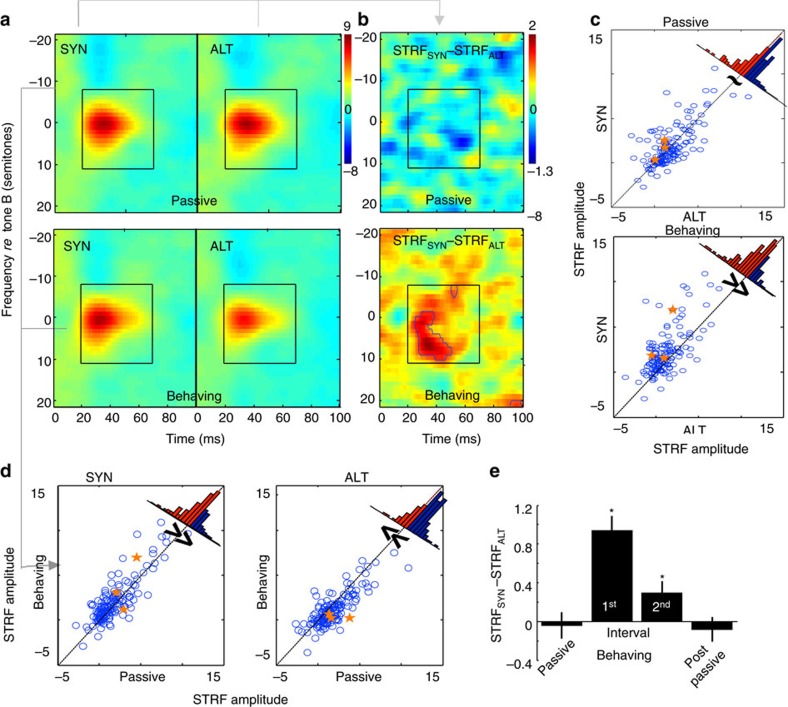
Average STRF changes across all cells.(a) Average STRF from all neurons in the passive and behaving states, and in two contexts: preceded by SYN or ALT sequences. The centers of the STRFs from all neurons were aligned at the CF of each neuron, which was typically near the frequency of the B tone sequence. The upper panels display the STRFs in the passive condition. The lower panels show the STRFs during behaviour. The highlighted central region is the window used for quantification and comparison. The same colour-scale is used for all STRFs. (b) Average differences in STRFs between SYN and ALT (STRFSYN-STRFALT). The upper panel shows that there were no significant STRF differences in the passive condition. During behaviour (lower panel), the STRF differences exhibit significant enhancement. The contours indicate the regions with statistically significant differences from zero (see Methods). The colour scale in these panels is magnified by 4.6 times compared to that of the in a. (c) Scatter plot of STRF amplitude in SYN versus ALT contexts for each neuron. Each circle represents one neuron. The value on y-axis indicates the mean of the normalized STRF amplitudes indicated by the colour-bar (in the highlighted box of a) obtained from SYN conditions, while the value on x-axis indicates the same mean STRF amplitude obtained from ALT condition. The distribution of the points is roughly symmetric during the passive state (top panel). It is biased above the midline in the behaving state (bottom panel). The distribution of all points is shown in the top-right hand corner, with red (blue) denoting the distribution above (below) the midline. Orange stars are the data points computed for the 3 single-units in Fig. 2. (d) Scatter plot of STRF amplitude in Behaving versus Passive conditions, measured exactly as in c above. For the SYN context, the distribution is biased significantly above the midline. For the ALT context, the distribution is biased significantly below the midline. Orange stars are the data points computed for the 3 single-units in Fig. 2. (e) Average STRF changes in SYN and ALT contexts (STRFSYN-STRFALT), measured during the first and second 800 ms intervals of the Target tone pips in behaving and passive conditions (pre- and the post-task). STRF differences were larger in the first interval than in the second, but both were significantly larger than zero (indicated by stars, P<0.001 for the first interval, P<0.01 for the second interval). No significant changes occurred during the pre-task and post-task passive conditions.